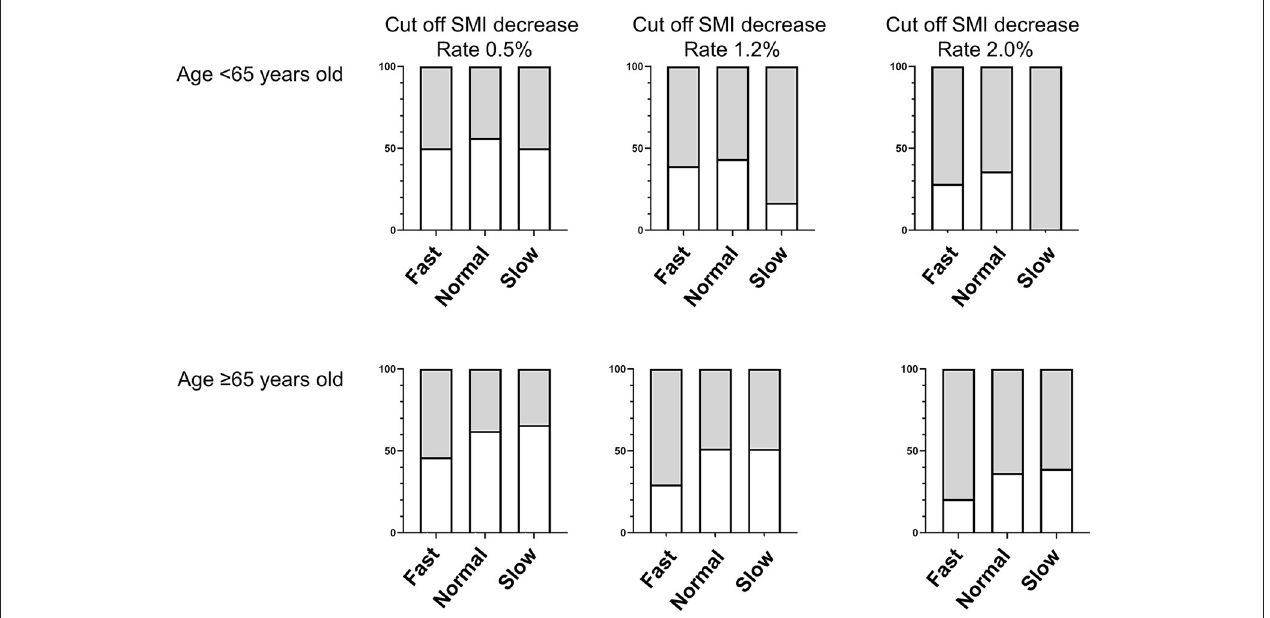
FIGURE 2 | Proportions of muscle mass loss among fast, normal, and slow speed eating by age (Cut–off levels of the rate of SMI decrease Rate 0.5%, 1.2% and 2.0%). Gray square represents the proportion of non–sarcopenia and white square represents the proportion of sarcopenia. their food intake (45, 46), and this might have had an effect on total energy and protein